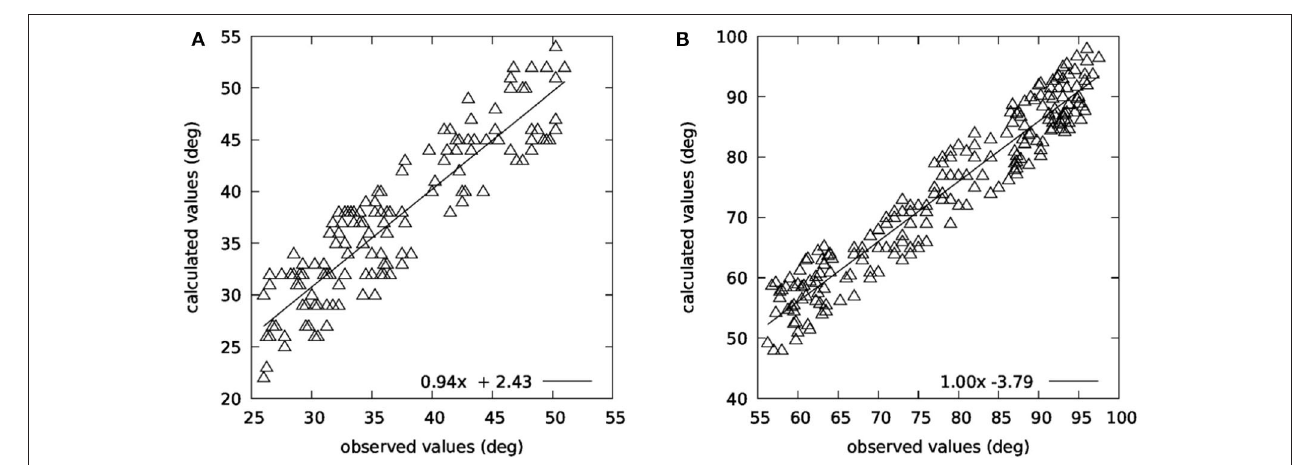
FIGURE 8 | Comparison between observed and calculated angles in (A) yaw and (B) pitch planes.